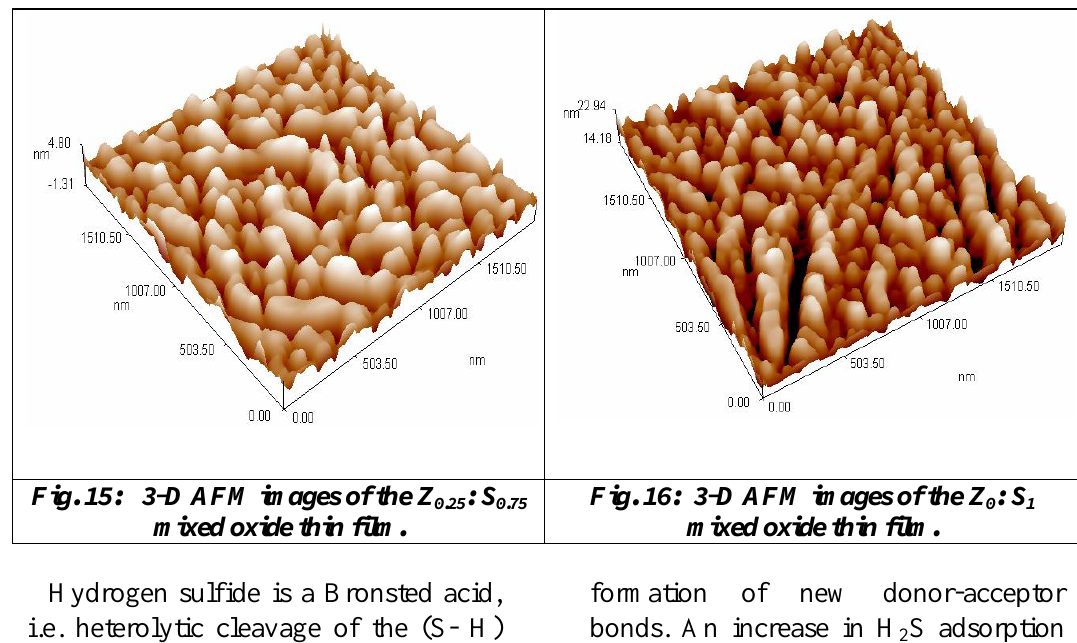
: S mixed oxide thin film. 0.5 0.5